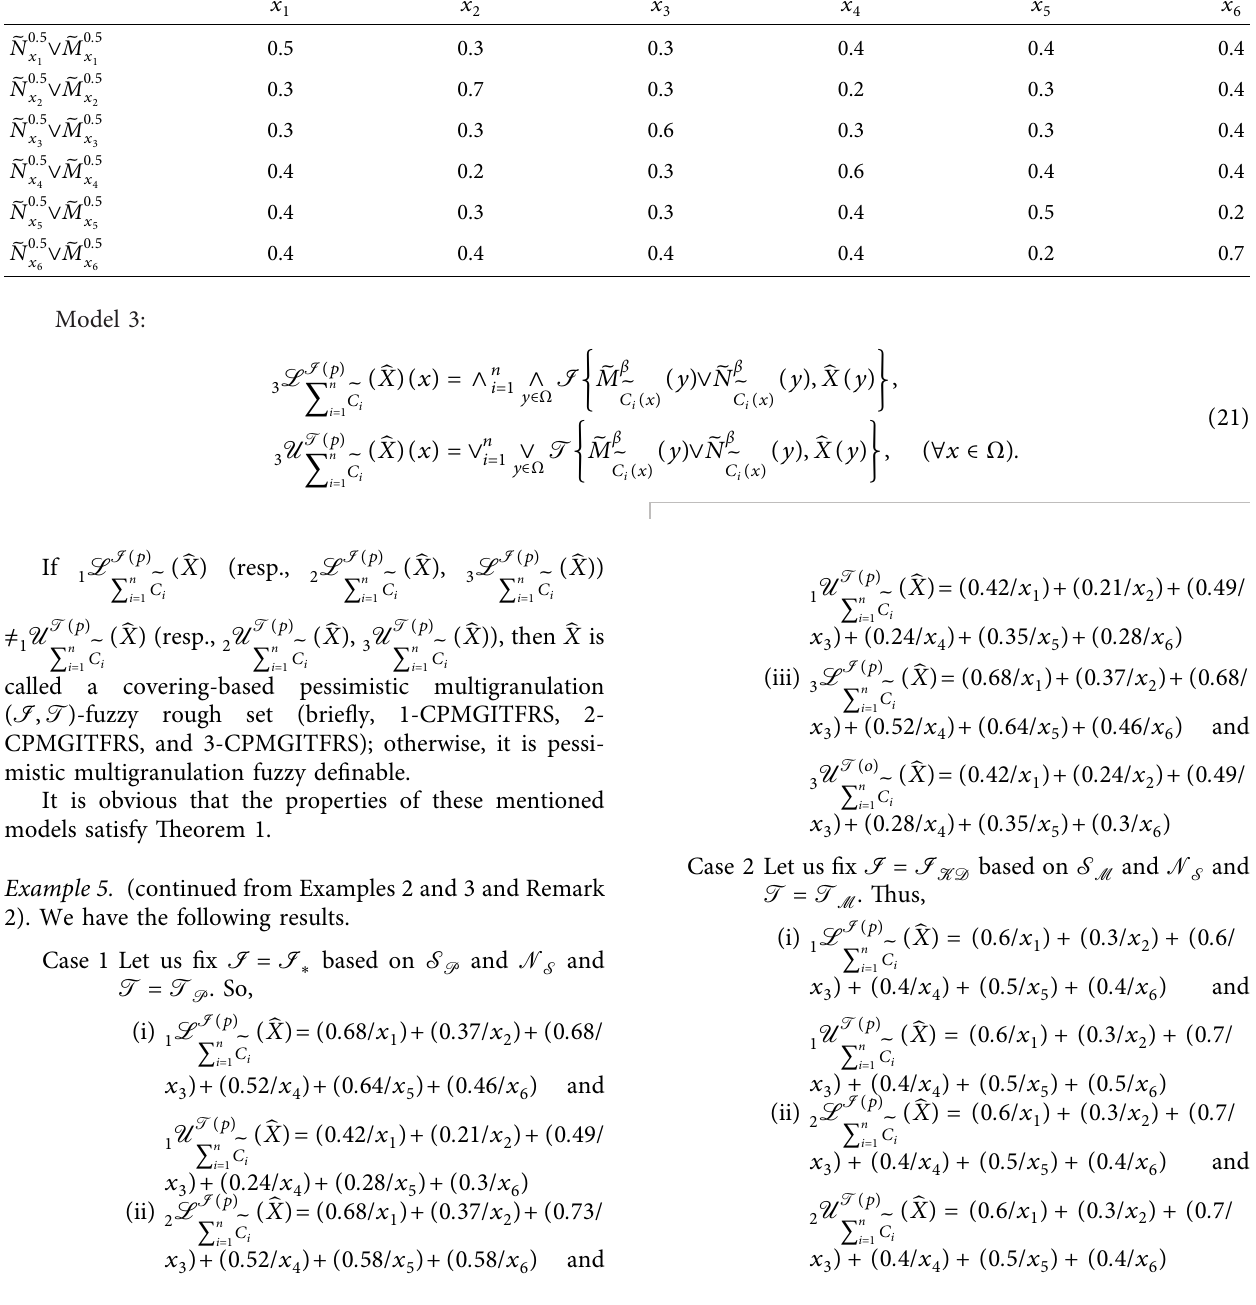
Table 10: Table for 􏽥 N β